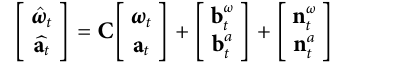
Frontiers in Robotics and AI |